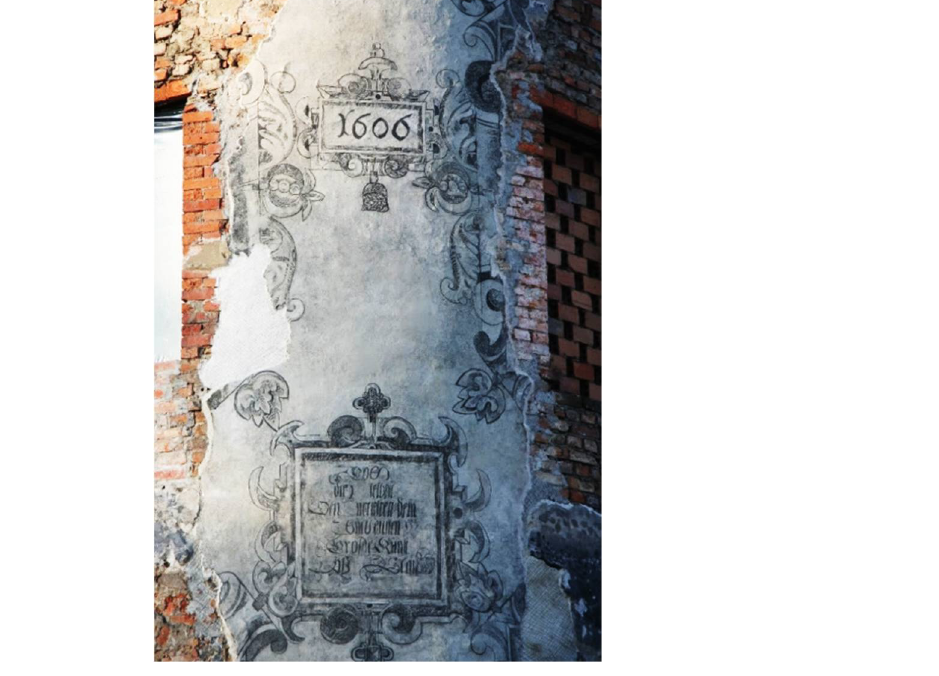
Figure 25. Sgraffito rollwork decorations on the walls of the palace in Broniszów (currently Zielona Góra Province). Photo by A. Legendziewicz, 2018.